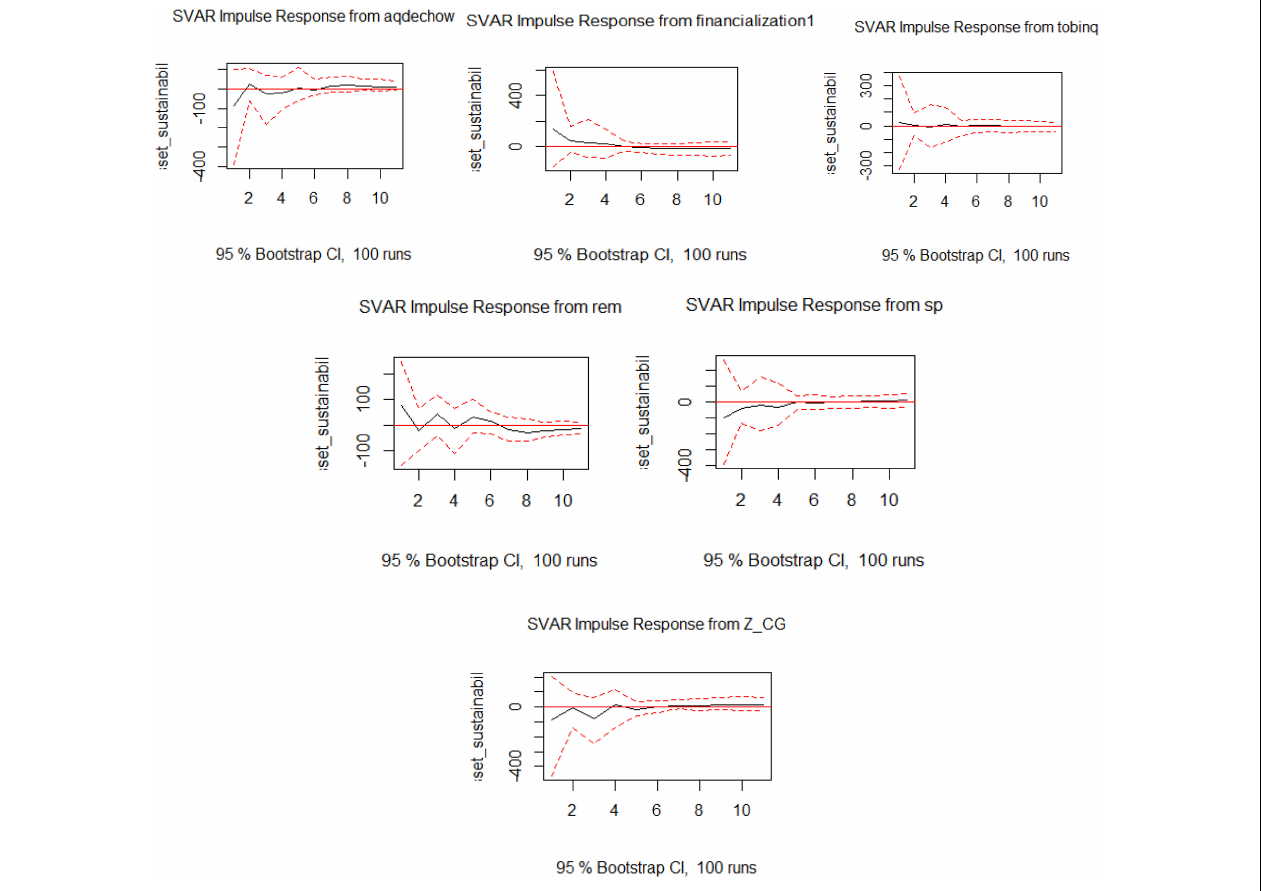
FIGURE 5 | Visualization of IRF for SVAR for Model